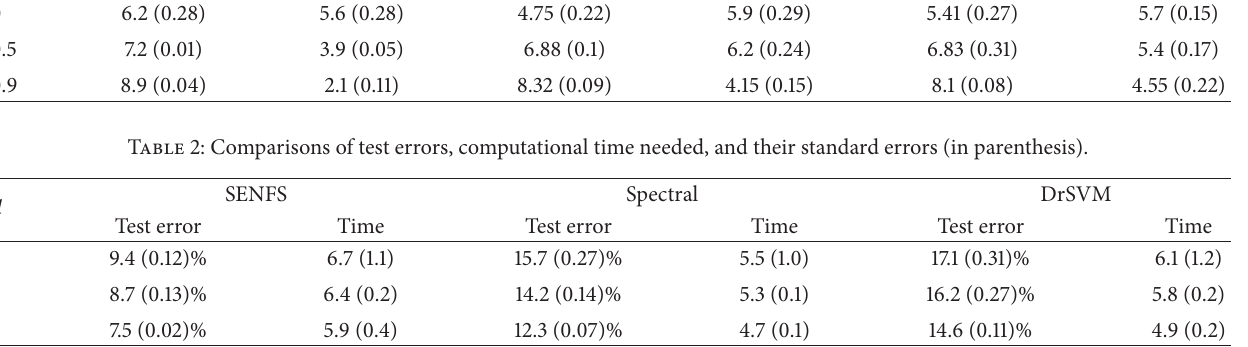
is the number of selected relevant features and relevant